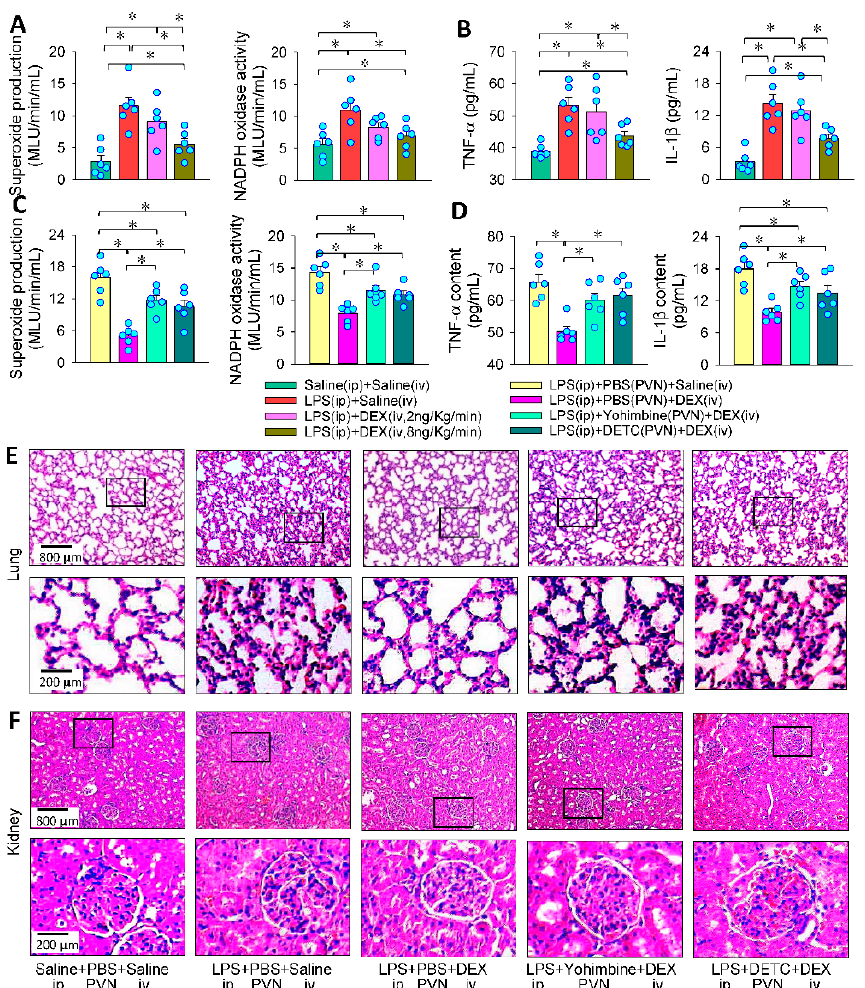
Figure 8. Roles of the PVN in the effects of intravenous infusion (iv) of DEX on the LPS-induced oxidative stress and inflammation. Intravenous infusion of DEX for 4 h was carried out 24 h